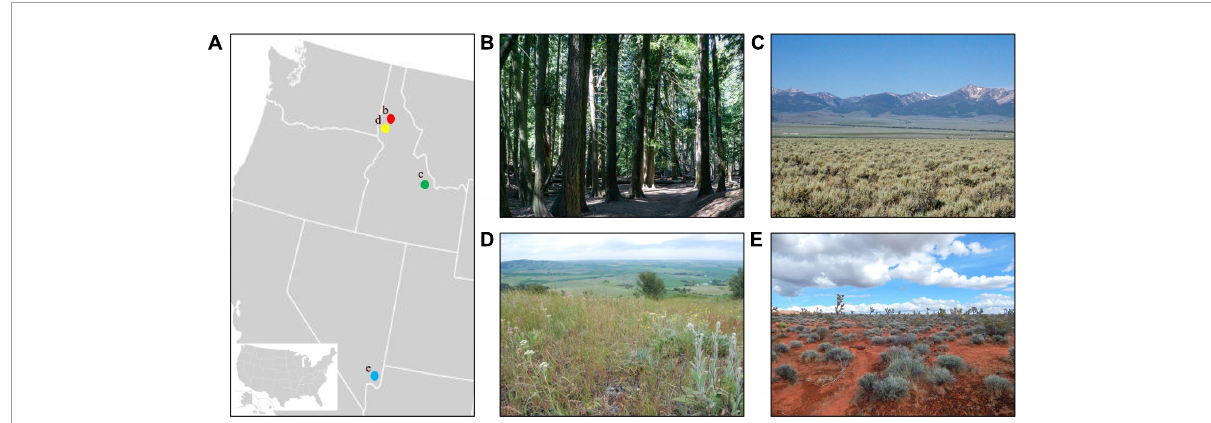
FIGURE2 (A) Locations of study sites in the western United States. (B) Forest site at the University of Idaho Experimental Forest near Moscow, ID (red dot). (C) Shrub-steppe site in the Lemhi Valley, ID (green dot). (D) Prairie site at the Dave Skinner Ecological Preserve and Thorn Creek Native Seed Farm near Moscow, ID (yellow dot). (E) Desert site at Gold Butte National Monument in southern NV (blue dot).